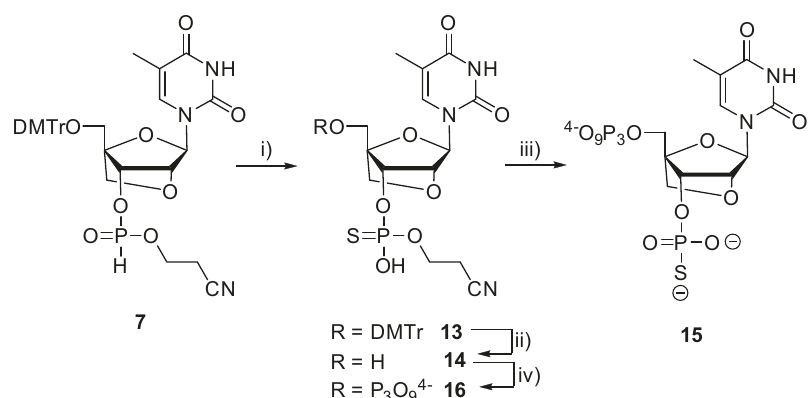
Fig. 8 Synthesis of 3 ′ -thiophosphate-LNA-TTP 15 and 3 ′ - β -cyano-thiophosphate-LNA-TTP 16. Reagents and conditions: (i) Beaucage reagent, pyridine, rt, 10 min, quantitative; (ii) TFA, DCM, rt, 60 min, quantitative; (iii) 2-chloro-1,3,2-benzodioxaphosphorin-4-one, pyridine, dioxane, rt, 45 min; 2. ( n Bu 3 NH) 2 H 2 P 2 O 7 , DMF, n Bu 3 N, rt, 45 min; 3. I 2 , pyridine, H 2 O, rt, 30 min; 4. NH 4 OH, MeNH 2 (1:1), rt, 2 h, 5% over 4 steps; iv) 2-chloro-1,3,2-benzodioxaphosphorin- 4-one, pyridine, dioxane, rt, 45 min; 2. ( n Bu 3 NH) 2 H 2 P 2 O 7 , DMF, n Bu 3 N, rt, 45 min; 3. I 2 , pyridine, H 2 O, rt, 30 min, 7% over 3